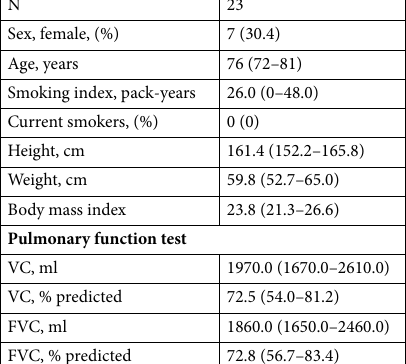
Lung and lobe volumes on CT, ml p value